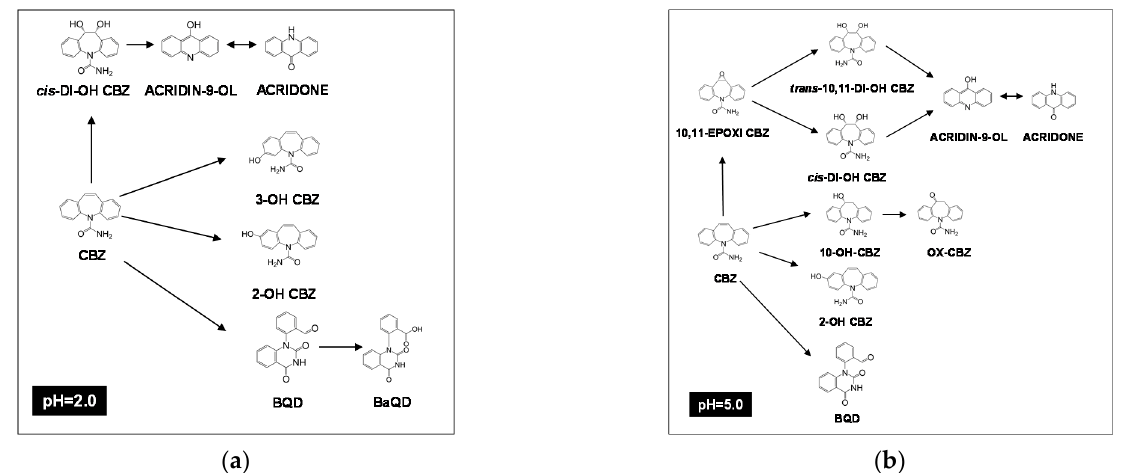
Figure 3. Equilibrium-species in carbamazepine aqueous solutions oxidized by photo-Fenton treatment. ( a ) Operating at pH = 2.0. ( b ) Operating at pH = 5.0. Experimental conditions: (CBZ) = 50.0 mg/L; (H 2 O 2 ) = 15.0 mM; (Fe) = 10.0 mg/L; (UV) = 150 W; T = 40 °C.